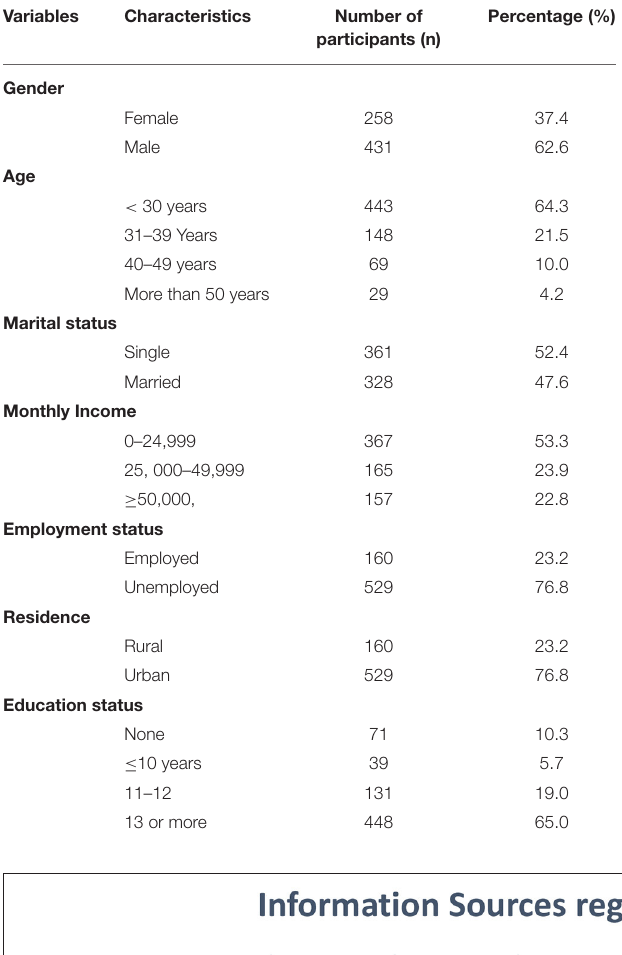
TABLE 1 | Demographic characteristics of study population ( N = 689).